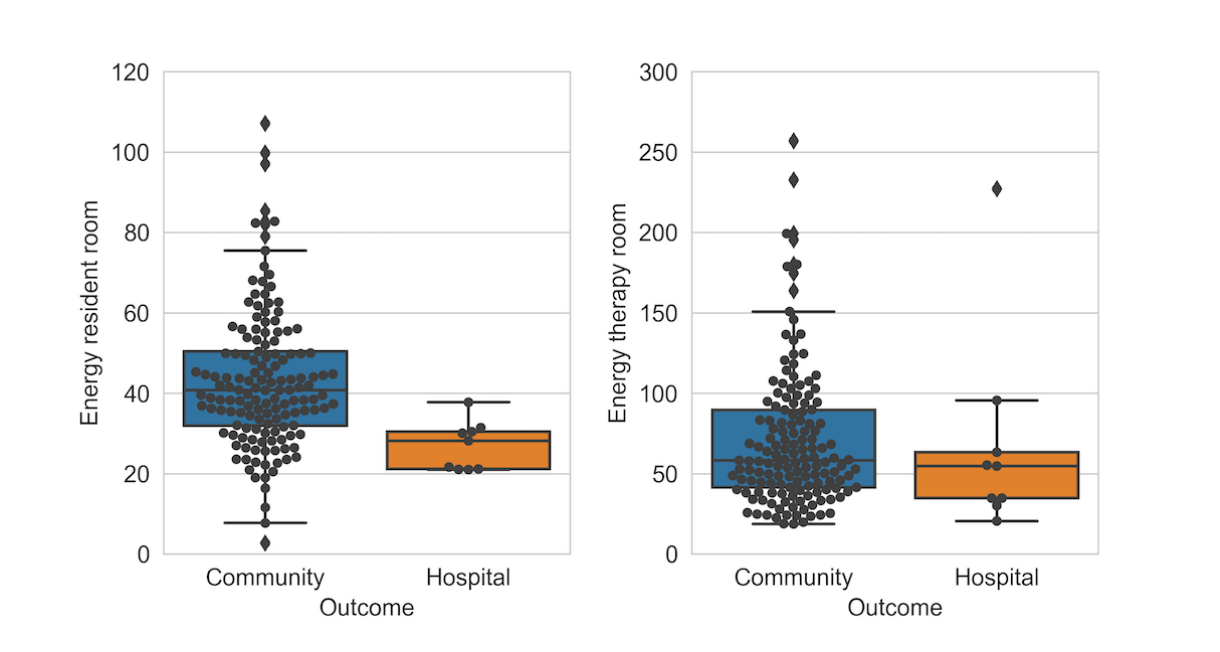
Figure 5. Energy intensity distribution.